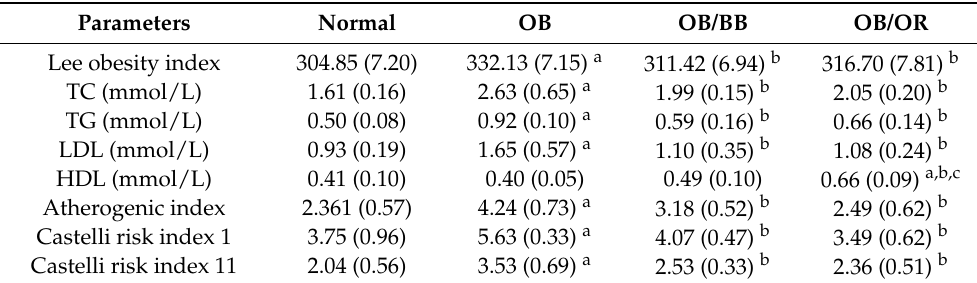
Table 1. Effect of bee bread on Lee obesity index, lipid profile and atherogenic ratios. Parameters Normal OB